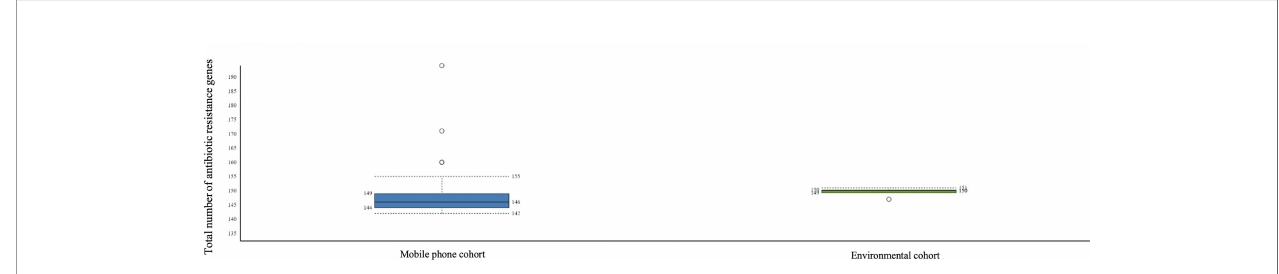
FIGURE 6 | Boxplot representing the number of antibiotic-resistant genes found per sample (left: mobile phone cohort; right: environmental cohort).